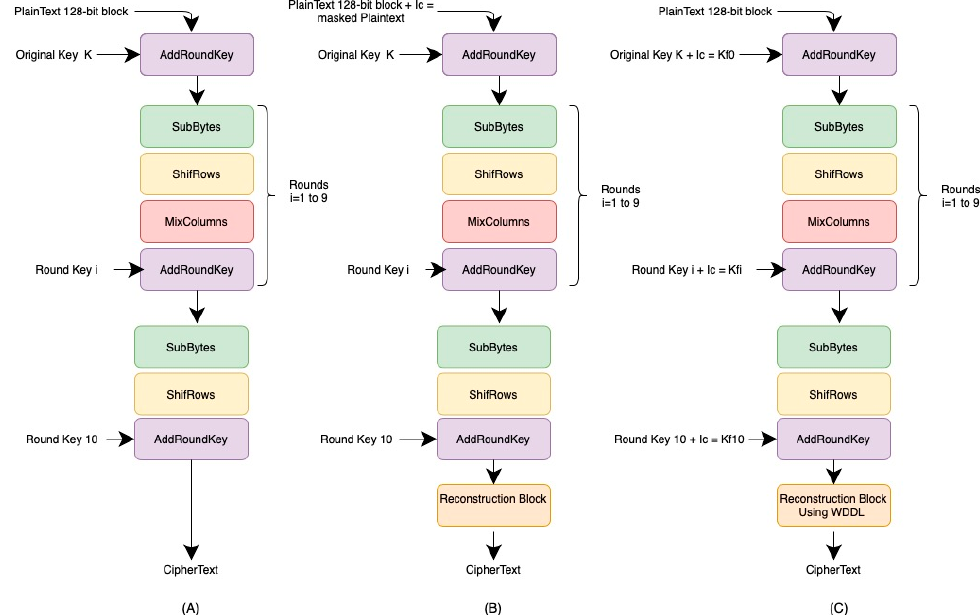
Figure 7. ( A ) Ten-round AES transformation schedule for 128-bit keys; ( B ) conventional AES masked implementation; ( C ) masked AES implementation based on the algorithm in [80].